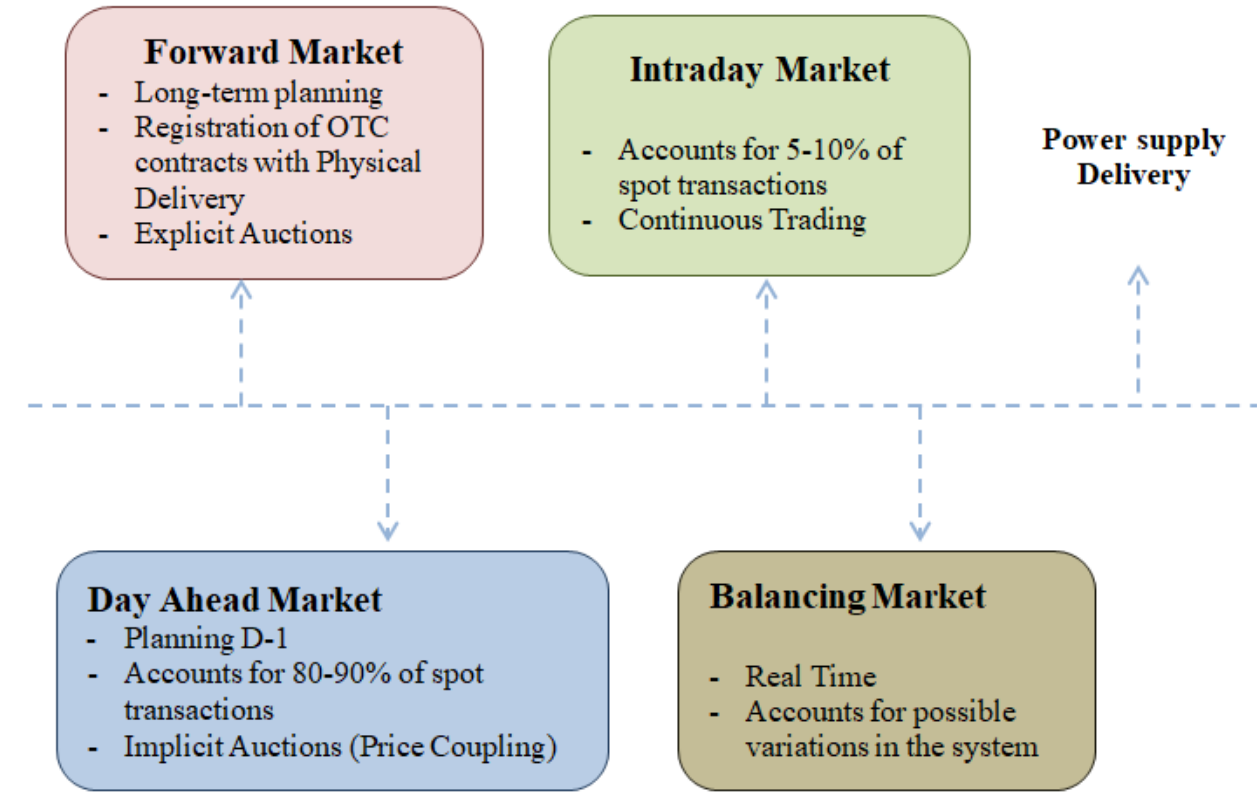
Figure 3. The new market structure in Greece [15].